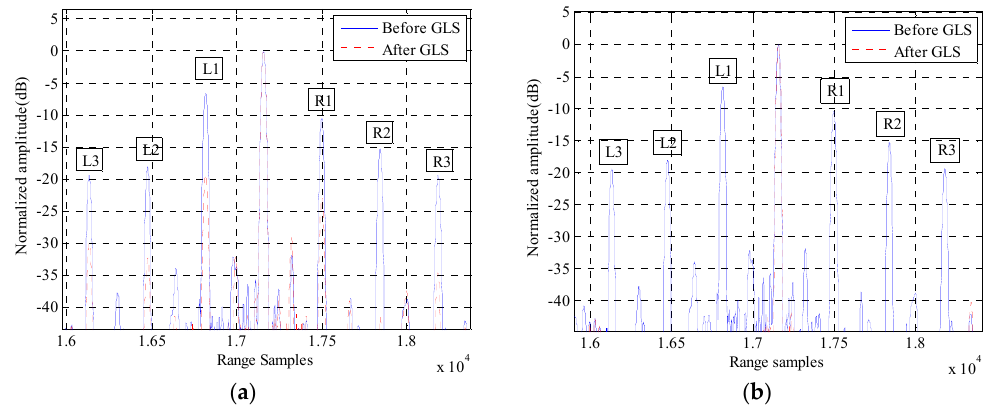
Figure 2. The HRRPs of a target before and after GLS: ( a ) GLS by GLPP; and ( b ) GLS by the proposed method.